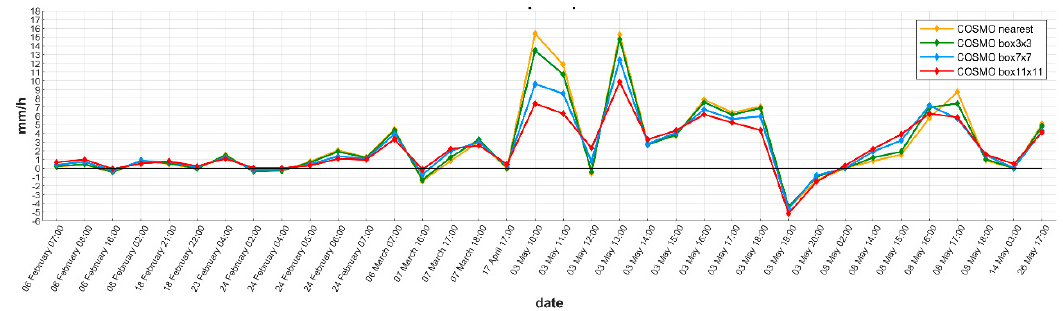
Figure 6. Bias of precipitation for selected days considering nearest point and grid boxes 3 × 3, 7 × 7 and 11 × 11.